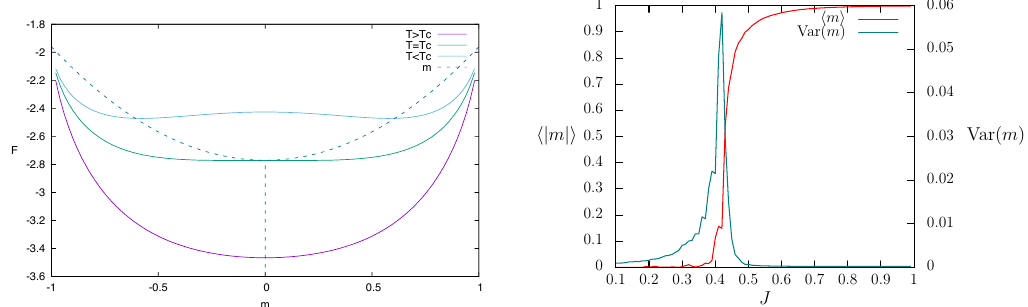
Figure 4. ( Left ) Plot of the free energy F as function of the magnetization m and for various temperatures T . The location of the minima, m ( ∞ ) is marked by the dashed line. ( Right ) Numerical simulations for N = 20 20 of the Ising model, by varying J and T = 1, average over 4000 time step, × after a transient of 4 10 4 ×